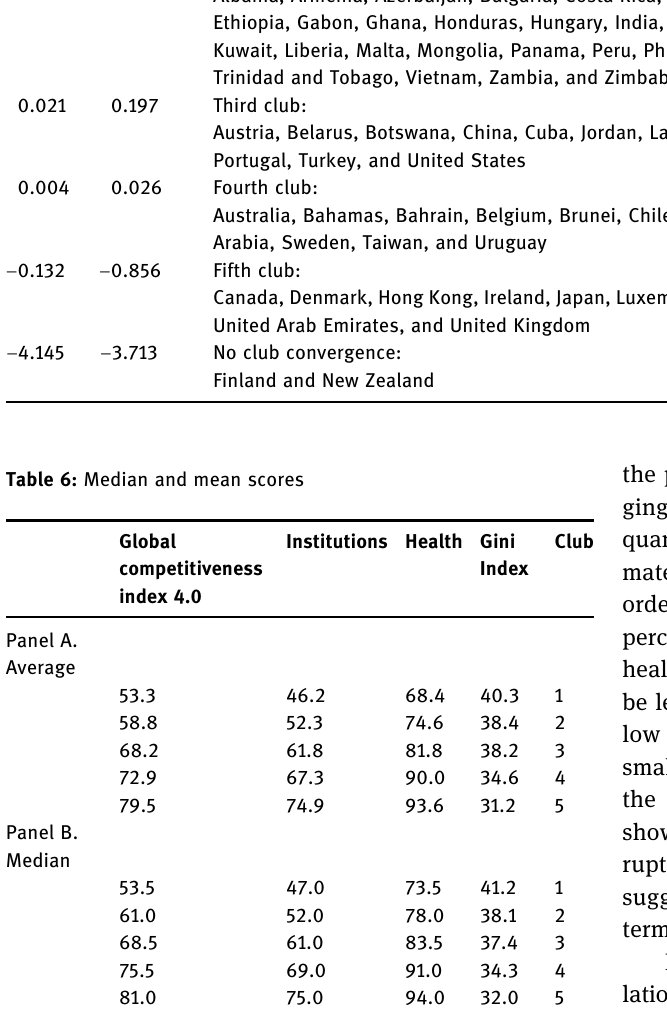
Source: Own elaboration from data of The Global Competitiveness Report